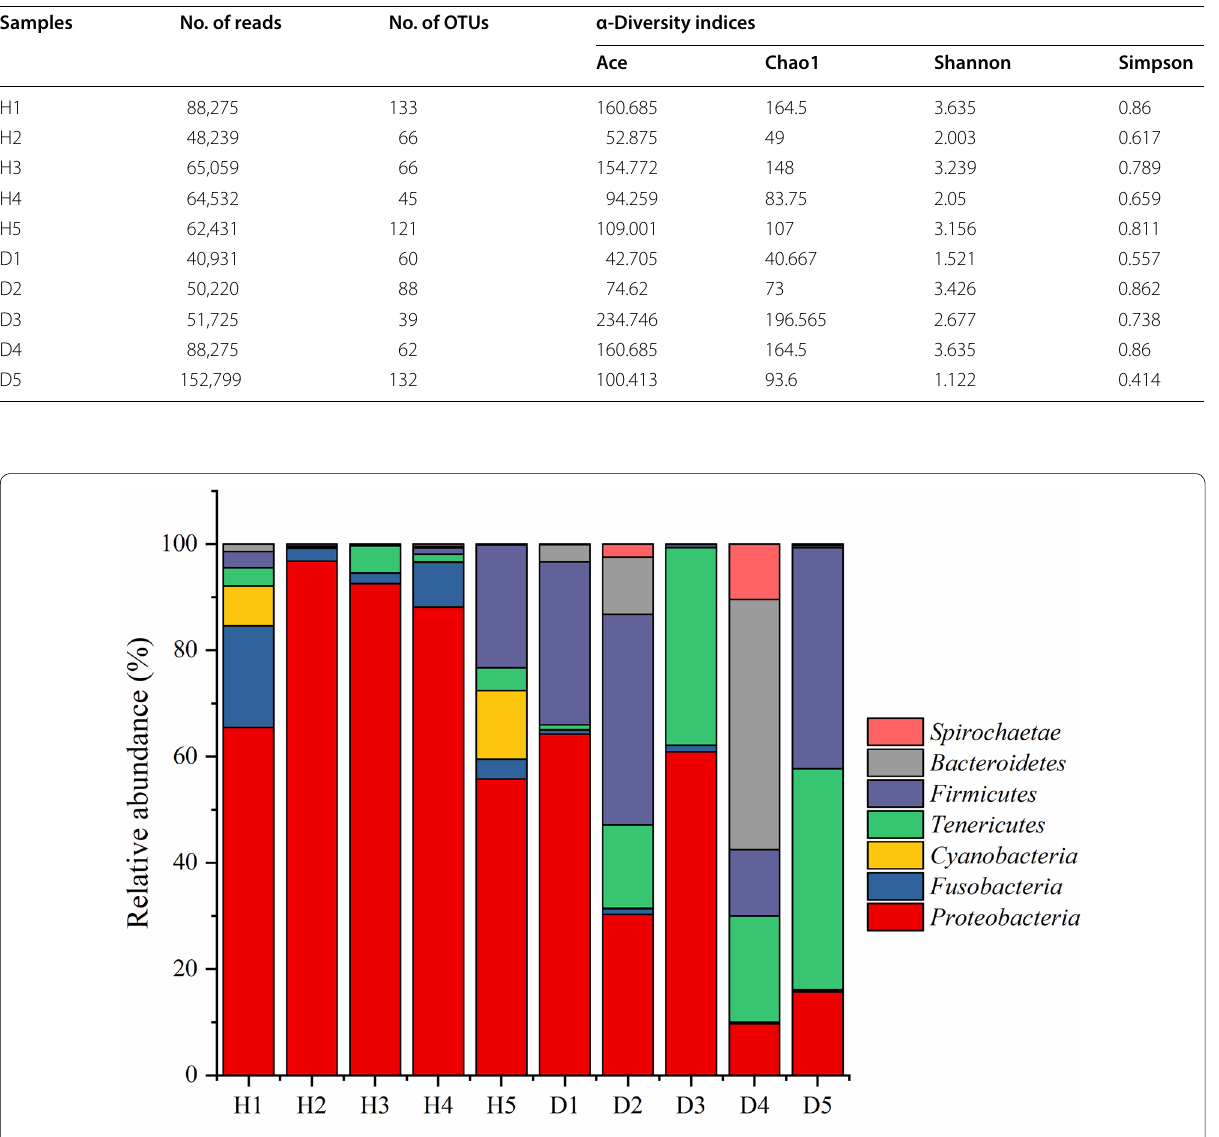
cated that the effect of Baimang disease on the intes- tinal bacterial communities was marginally significant (Pseudo-F 1.8828, P -perm 0.064) and the order com- = = munities of Vibrionales and Clostridiales was margin- ally significant (independent-samples t test, F 1.918 = and 2.116; P 0.091 and 0.067). In addition, the Axis 2 = (PCO2) of PCoA analysis separated the healthy group 0.839, 0.931, from the diseased group (Fig. 3). First two axes (PCO1 =